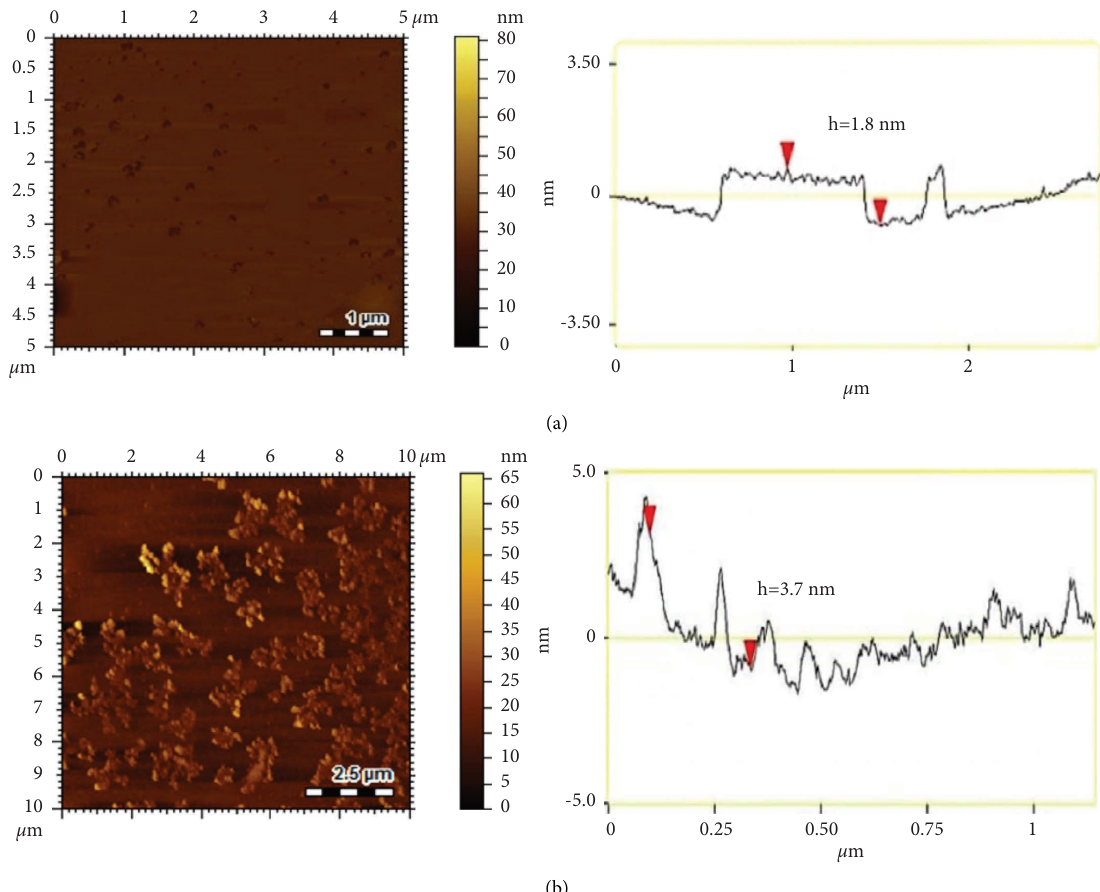
Figure 5: AFM images of NGO-PEG-BPEI-CDDP and NGO-PEG-BPEI-CDDP@Antibody. (a) Te typical AFM two-dimensional image of NGO-PEG-BPEI-CDDP shows a smooth sheet with some wrinkles and burrs (left); an average thickness of about 1.8 nm (right); (b) the typical AFM two-dimensional image of NGO-PEG-BPEI-CDDP@Antibody (left); the thickness (3.7nm) and roughness (Ra ∼ 0.96 nm) were further increased